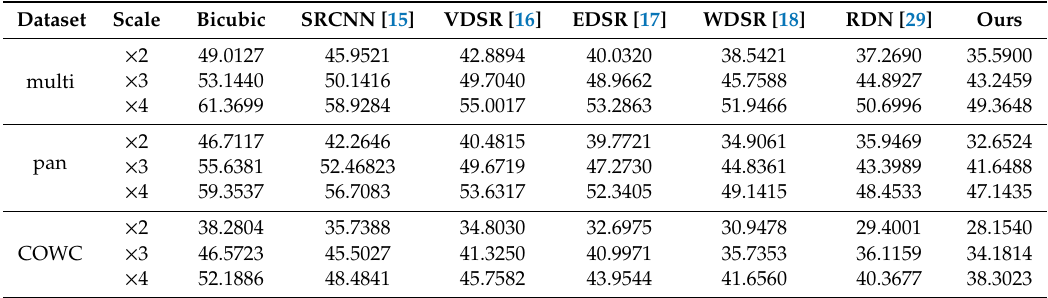
Table 4 . Average BRISQUE results at scales ×2, ×3, and ×4 on our GF-2 datasets and the COWC datasets. The red color indicates the best performance.